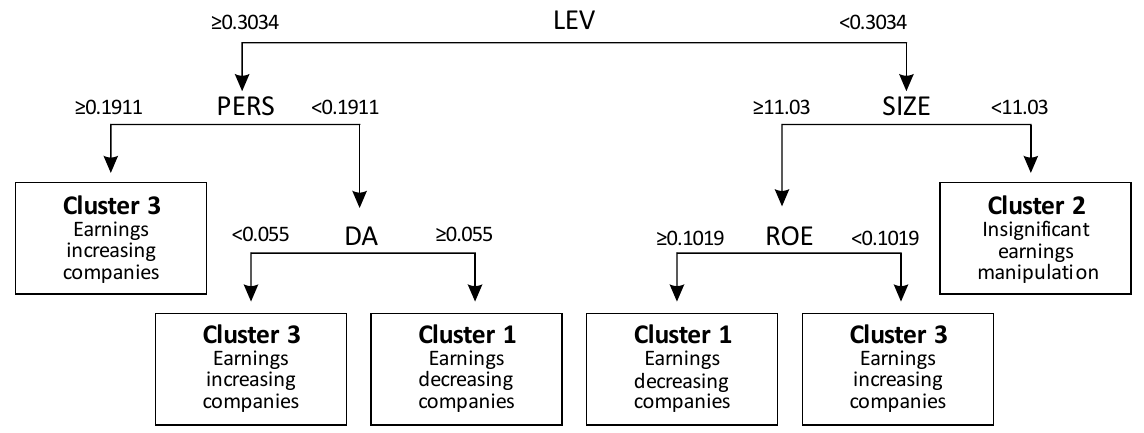
Figure 3b. Decision tree to determine clusters of earnings management